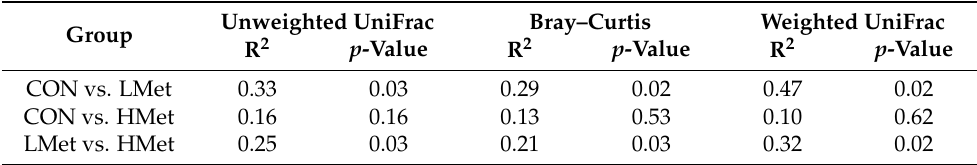
Figure 3. Comparisons of the bacterial communities in the rumen of sika deer. Principal coordinate analyses based on unweighted UniFrac distances ( A ), Bray–Curtis distance ( B ), and weighted UniFrac distance ( C ). Table 7. Adonis analysis of the bacterial communities in the rumen of sika